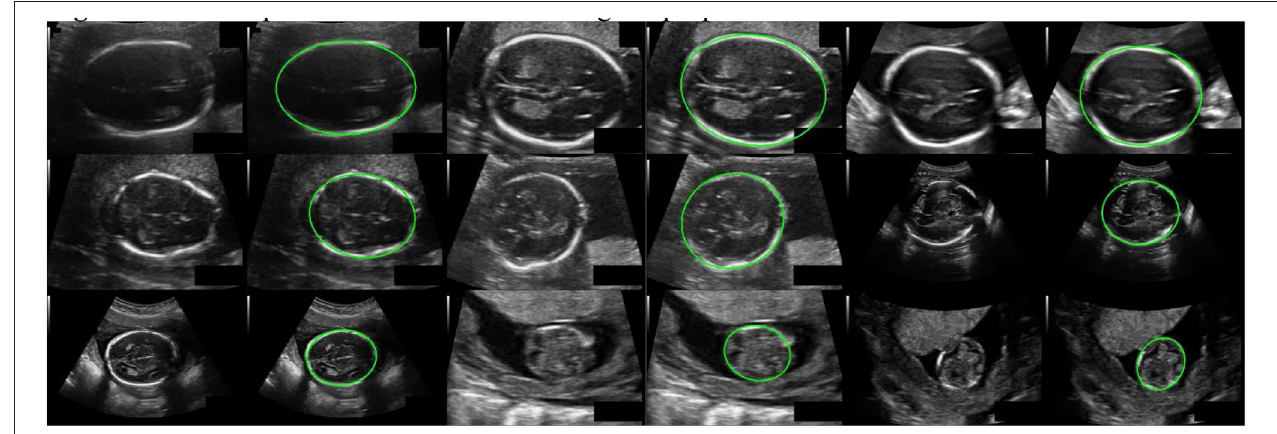
FIGURE 7 | Some examples of detection results using the proposed